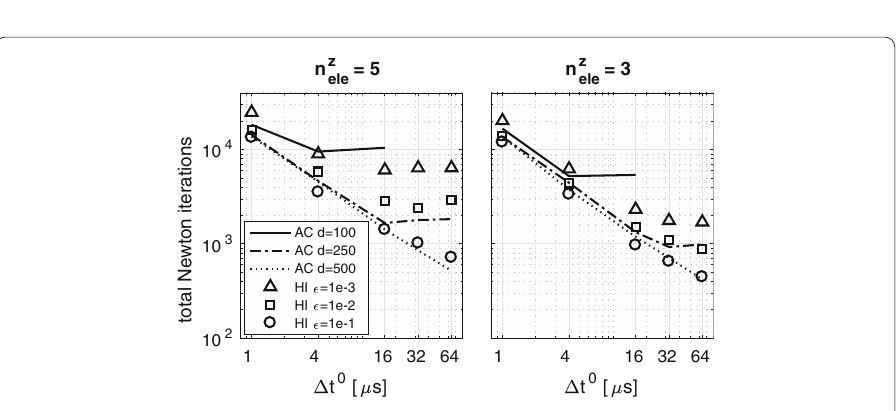
Fig. 25 Total number of Newton iterations required for different initial time step sizes (cid:11) t 0 in the time step halving